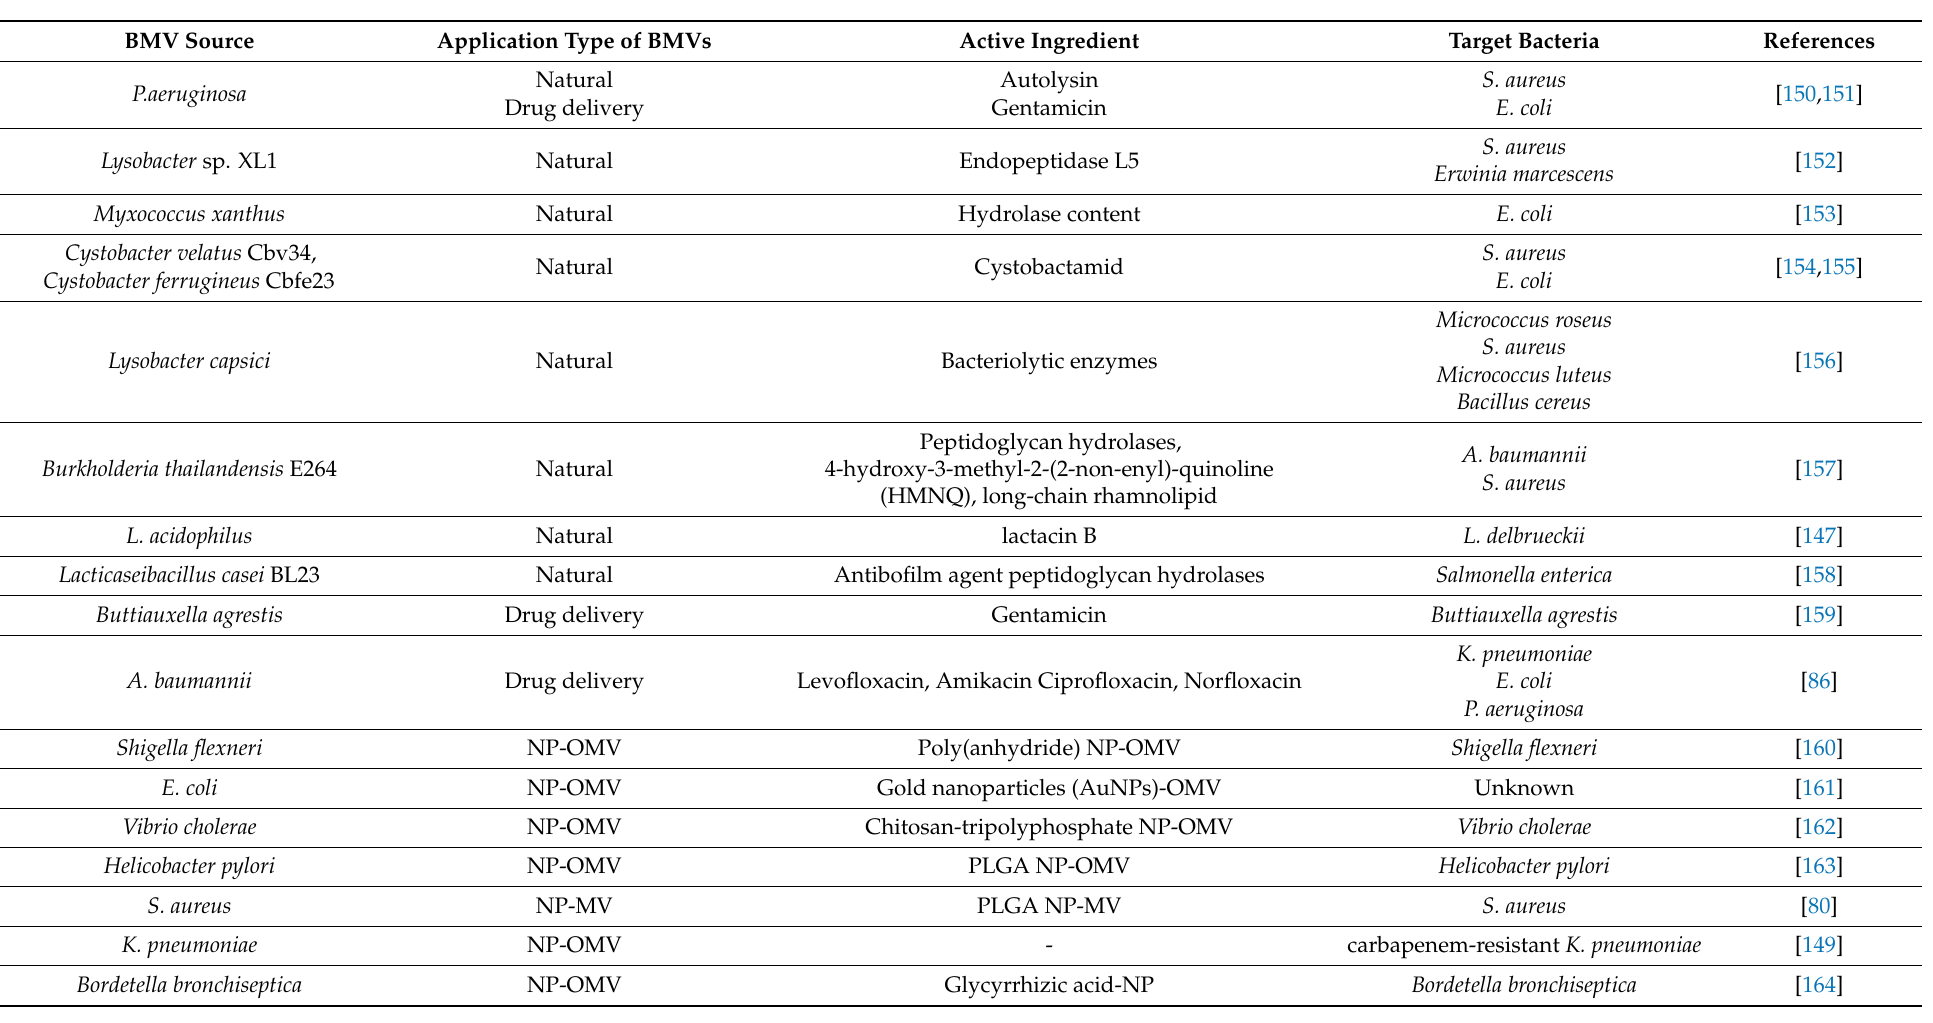
Table 4. Antibacterial effect studies of